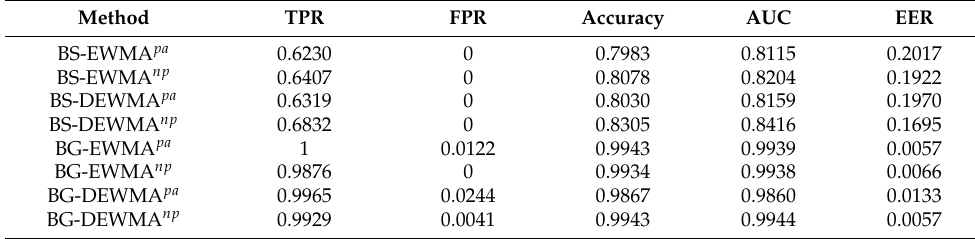
Table 10. Detection results by procedure when two modules are short-circuited.